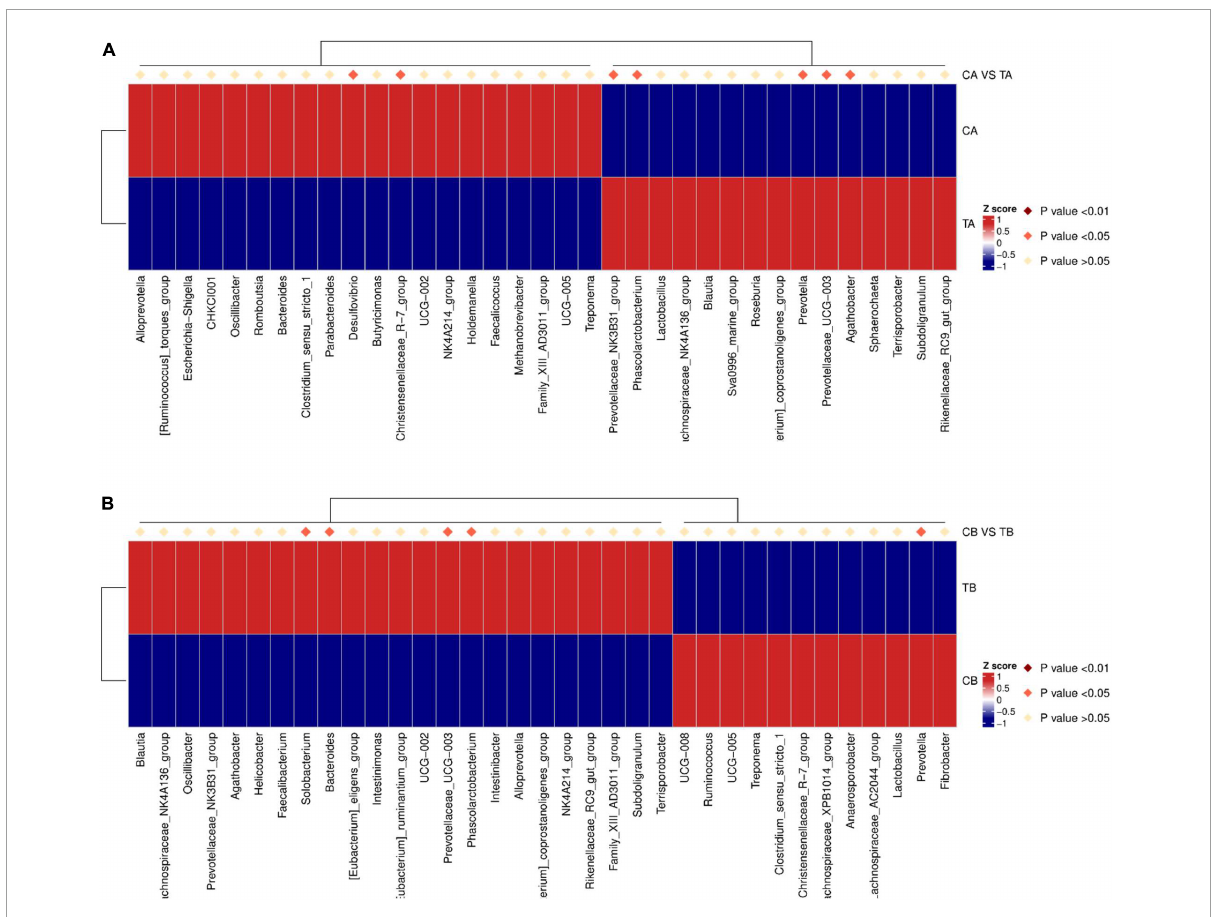
FIGURE6 Top 35 species abundance clustering with ComplexHeatmap (genus level) for intestinal microbiota of piglets weaned on day 14 of age (14W) and day 28 of age (28W) at different sampling timepoints [day 28 of age (A) ; day 70 of age (B) ]. Underside represents the species annotation information. Upside represents the contrast between the groups. The corresponding value of the heat map is the Z value of the relative abundance of species in each row after the normalization treatment. CA group was defined as the sample from piglets in 28W group at the timepoint of day 28 of age. TA group was defined as the sample from piglets in 14W group at the timepoint of day 28 of age (A) . CB group was defined as the sample from piglets in 28W group at the timepoint of day 70 of age. TB group was defined as the sample from piglets in 14W group at the timepoint of day 70 of age (B)